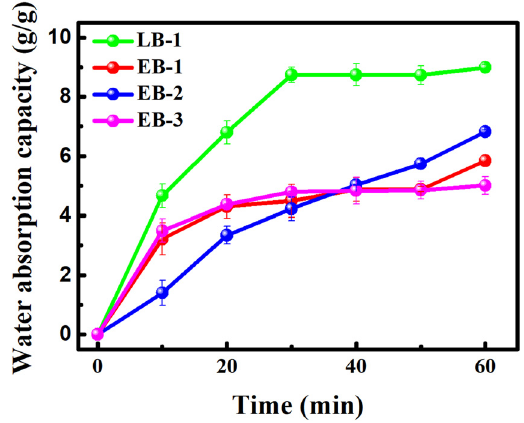
Table 5: Comparison of properties between enzymatic and